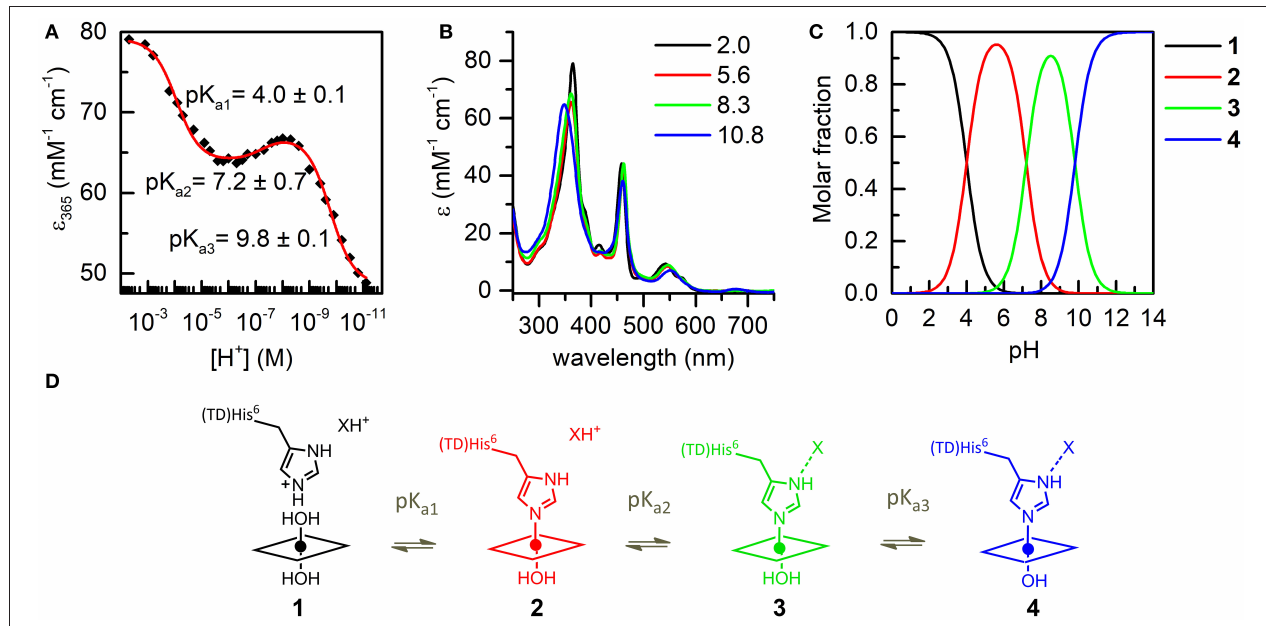
FIGURE 4 | UV-vis pH titration of Mn-MC6*a (15 µ M) in aqueous solution containing 40% TFE ( v/v ), T = 25 ◦ C. (A) Plot of the ε 365 (Soret) variation as a function of [H + ]; data points were fitted according to equation 8 (ESI). (B) Absorption spectra of the four species involved in the acid-base equilibria. Curves of different colors represent the different pH values, as indicated in the legend. (C) pH-dependent speciation diagram obtained from the titration data. (D) Schematic representation of the acid-base equilibria.